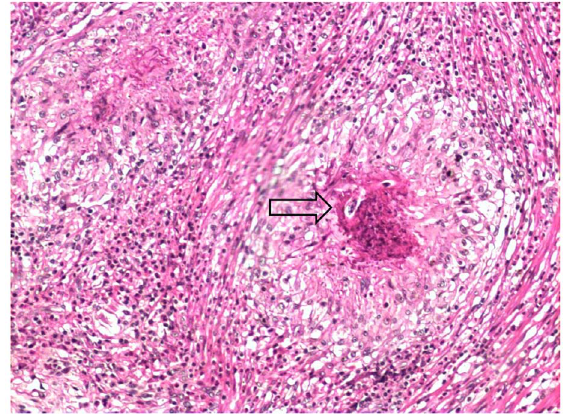
Figure 1. A confirmed case with worms of Angiostrongylus costaricensis inside mensenteric artery (H&E, 200x).